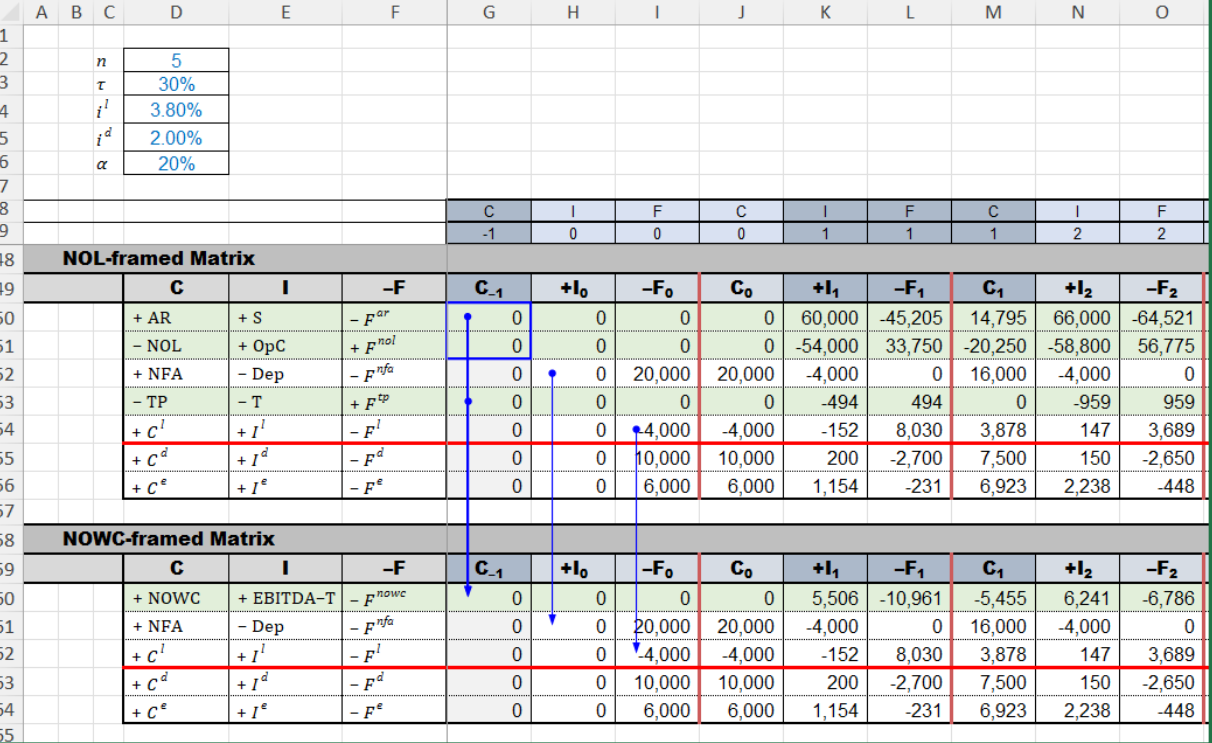
Figure 29. The strip of NOWC-framed matrices (“SplitScreenStrip” sheet). The rows with the same color in the NOL-framed Matrix are consolidated into one row of the same color in the NOWC- framed Matrix.